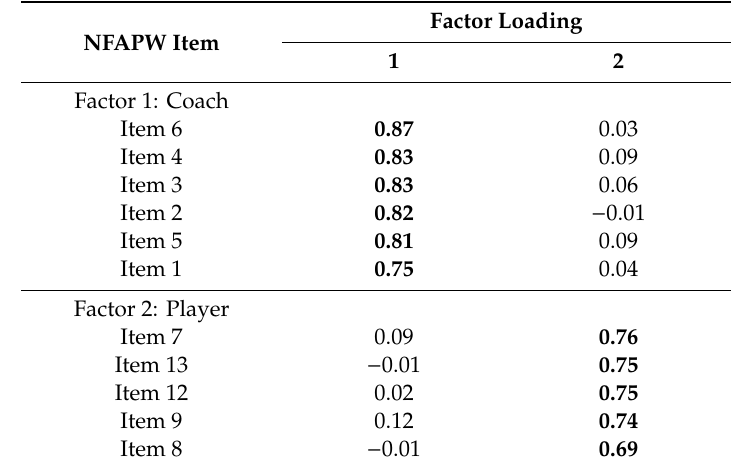
Table 4. EFA results for the NFAPW.